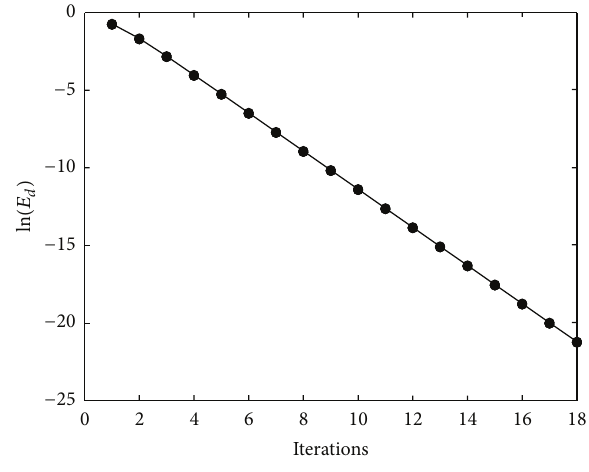
Figure 1: Comparison of Logarithm of error 𝐸 𝑑 for the Blasius boundary layer computed using the SLLM without SOR, SLLM with SOR ( 𝜔 = 1.2 ), and SQLM